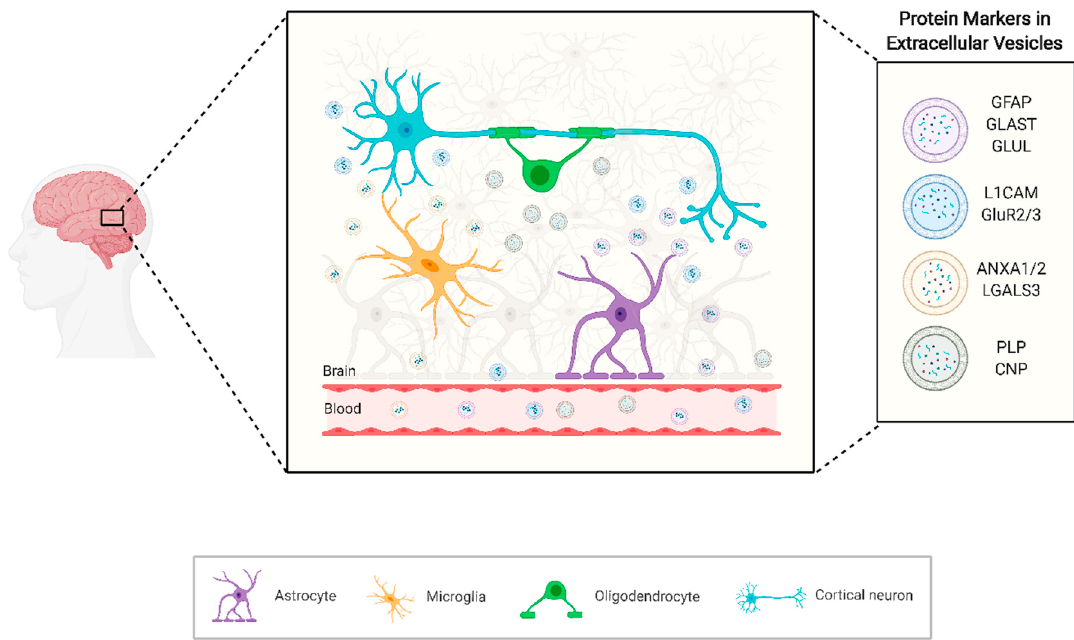
Figure 2. Schematic representation of the brain microenvironment, its main cellular components and how the brain–blood- barrier permeability allows for extracellular vesicles to reach circulation. Created with BioRender.com.